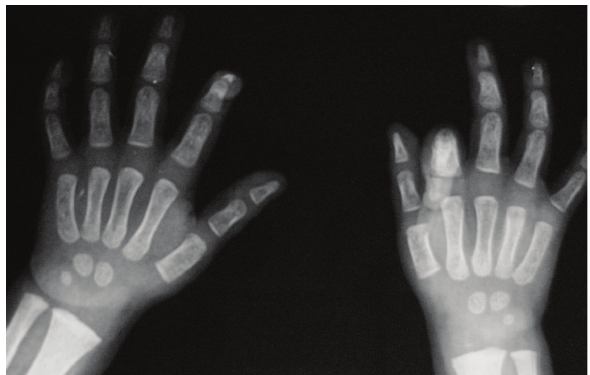
Figure 1: Plain radiographs showing little cortical hyperdensity of right hand fourthmetacarpal.